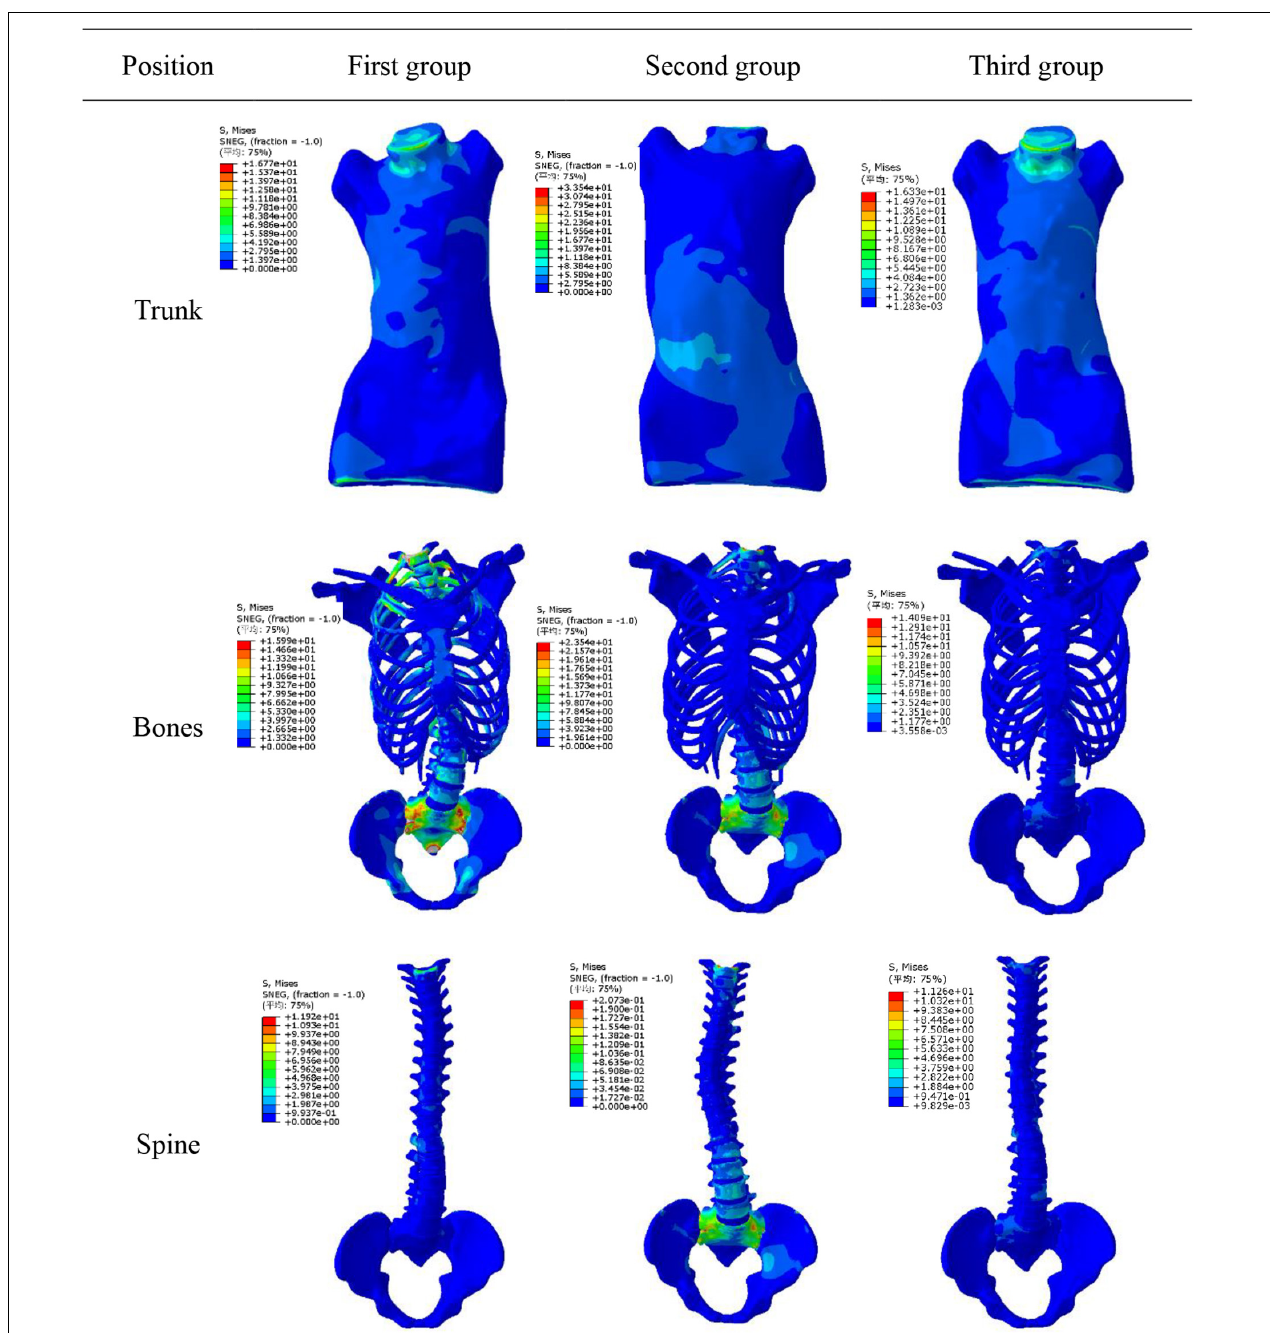
FIGURE 8 | Stress